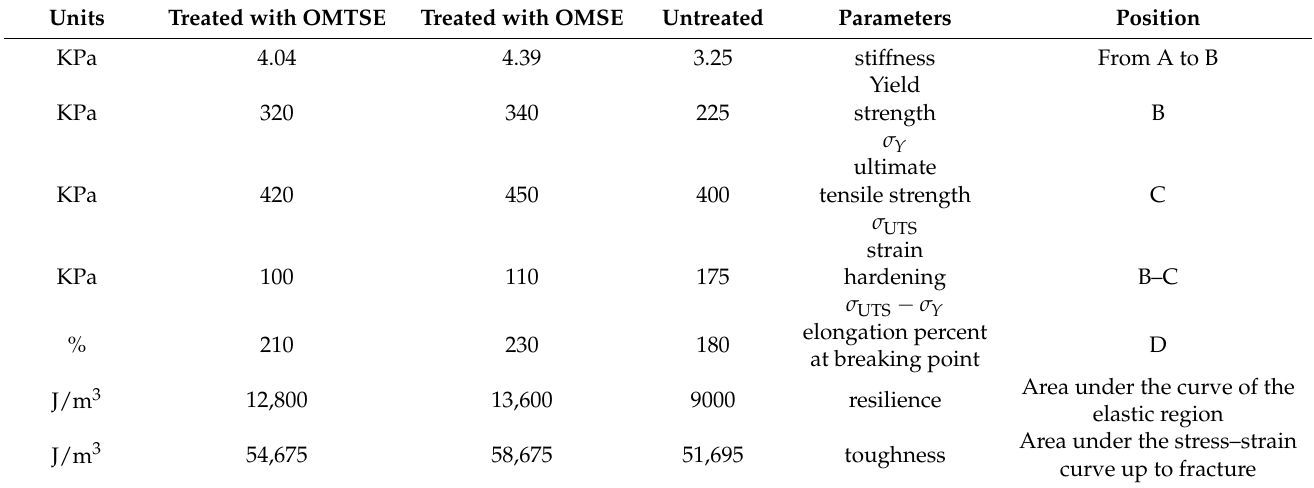
Table 1. The measured mechanical properties of the untreated samples and OMSE and OMTSE treated samples. Units Treated with OMTSE Treated with OMSE Untreated